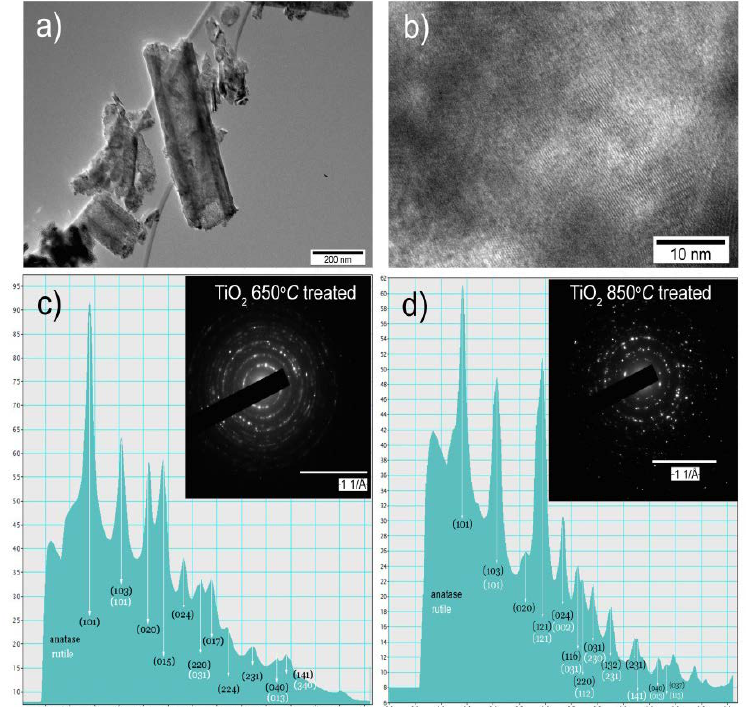
nanotubes: (a) an overview image of nanotubes; (b) high Figure 2. TEM analysis of TiO 2 resolution image of nanotube wall; selected area electron diffractogram and rotational average diagram of TiO nanotubes treated at (c) 650 °C, and (d) 850 °C 2